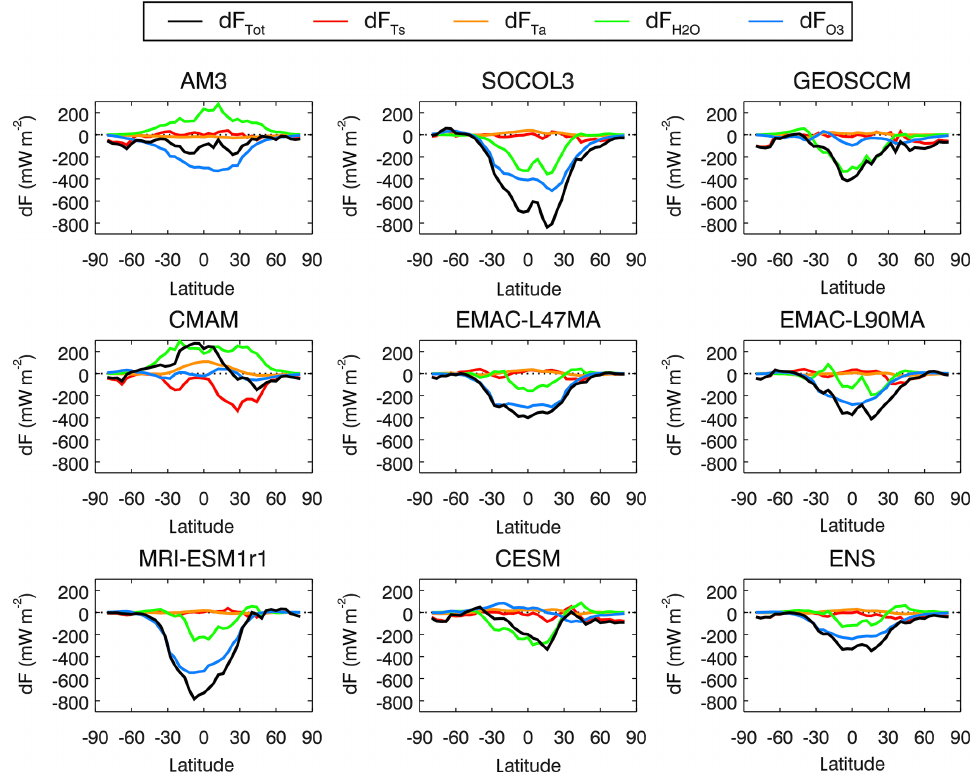
Figure 4. The attribution of the total TOA flux bias for each model to four dominant components and their latitudinal distribution. The black curves are the same as the colored curves in Fig.